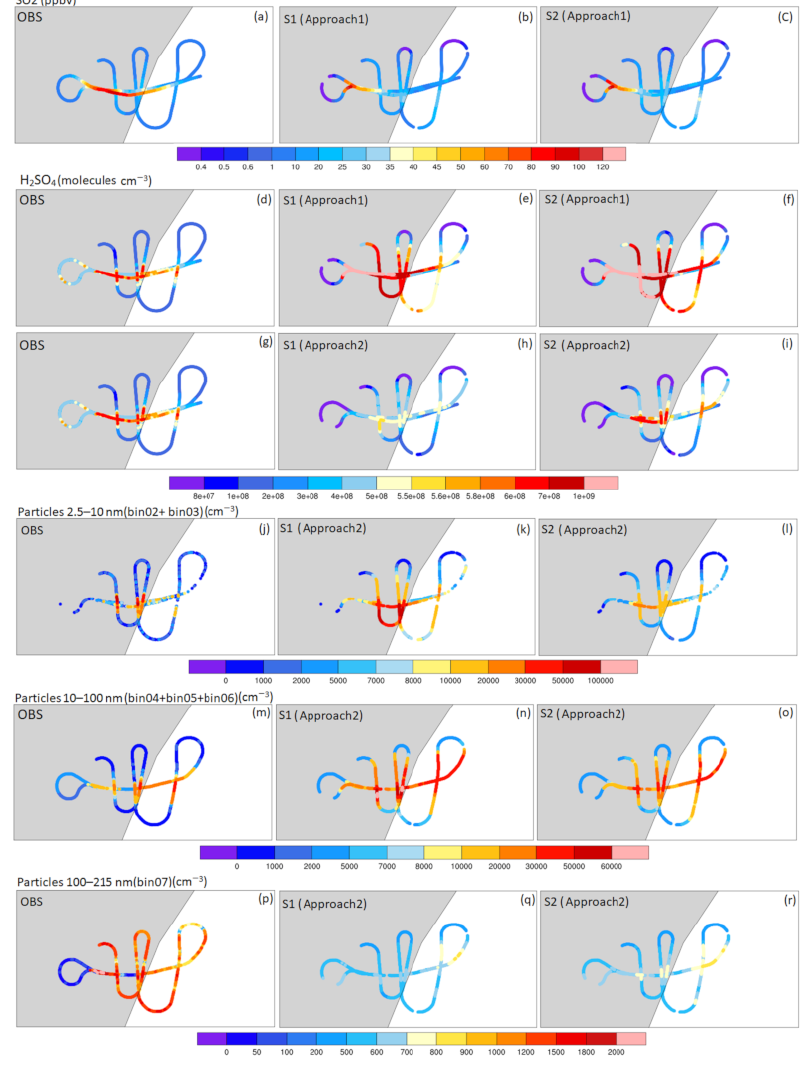
Figure 4. Evolution of SO 2 concentrations ( a – c ), (H 2 SO 4 ) ( d – i ), ~2.5–10 nm-sized newly-formed particles (N 2.5–10 ) ( j – l ), 10–100 nm-sized particles (N 10–100 ) (m-o), and ~100–200 nm CCN-sized particles (N 100–200 ) ( p – r ) along the aircraft trajectory, using the analysis Approaches 1 or 2 (see Section 2.3). OBS corresponds to the measurements obtained during the flight ETNA13 (10:45–11:15 UTC). S1 and S2 correspond to simulations that respectively use the activation parameterization for nucleation and the